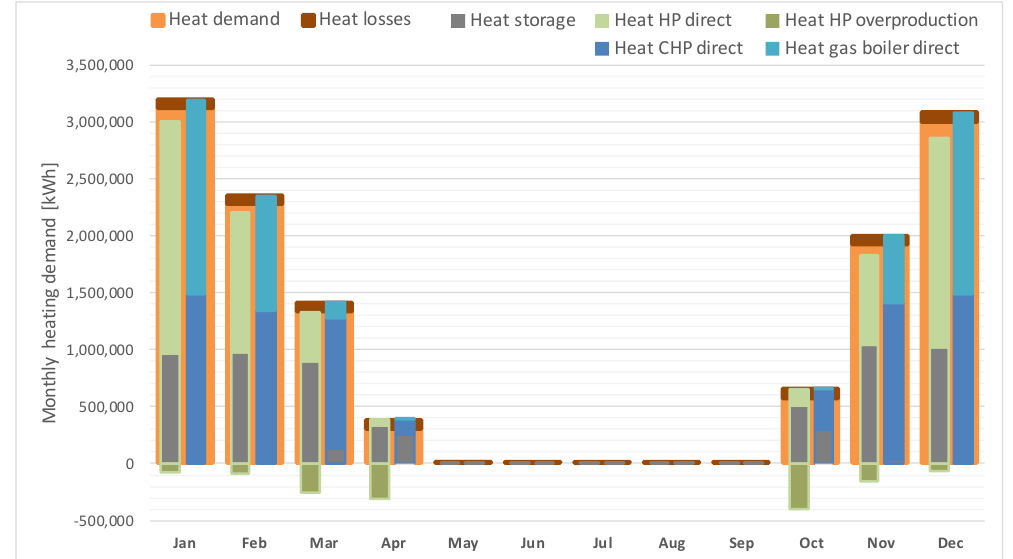
Figure 11. Coverage of heat demand by HP and CHP systems